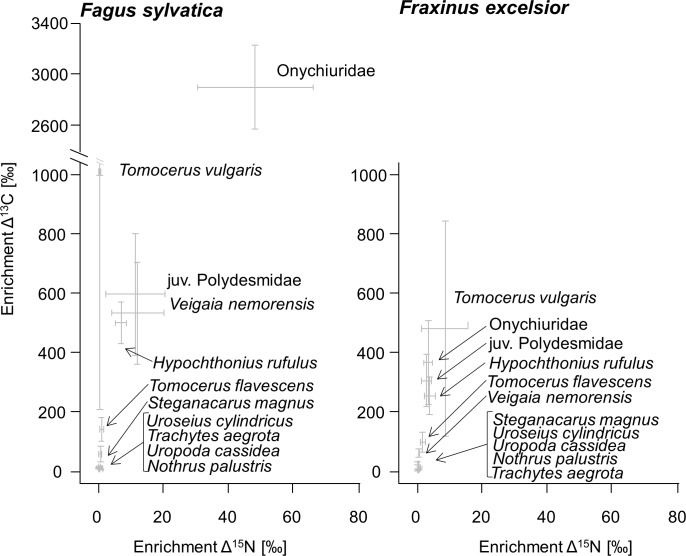
Enrichment in 15N and 13C in soil animal species / taxa.Enrichment in 15N and 13C in soil animal species / taxa in the rhizosphere of beech (Fagus sylvatica) and ash (Fraxinus excelsior). Means and standard error (SE). Note the axis break on the y-axis between 1000 and 2600 ‰.